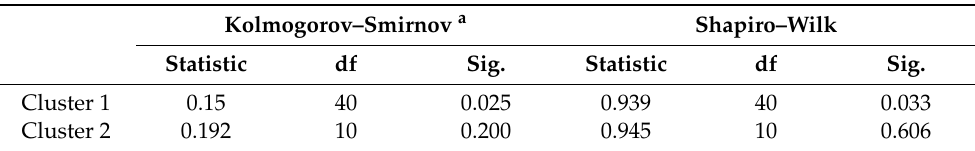
Figure 5. Box-plot cluster. Source: own processing data in SPSS 23. Normality tests for the two clusters can be seen in Table 7. Table 7. Test of Normality.